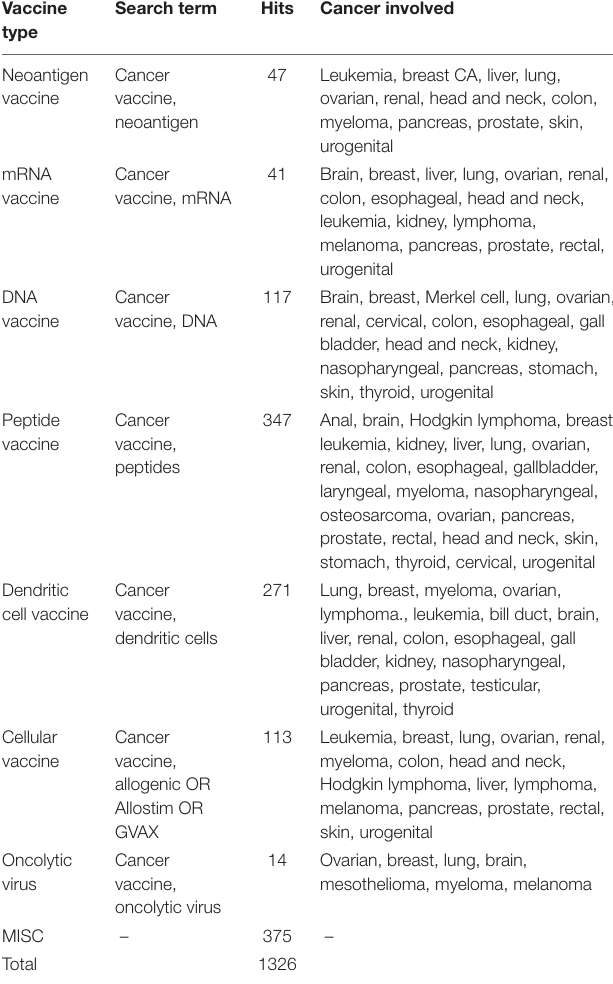
TABLE 1 | Types of cancer vaccine that are having on-going or completed clinical